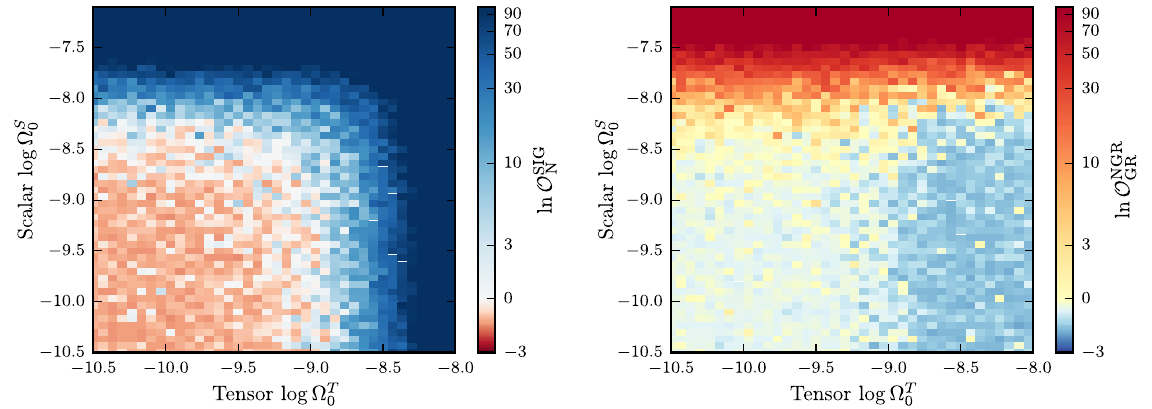
FIG. 9. As above, but for simulated 3-year observations with the joint Advanced LIGO-Virgo network at design sensitivity. Despite the inclusion of Advanced Virgo, the sensitivity of this three-detector network is nearly identical to that of Advanced LIGO alone.